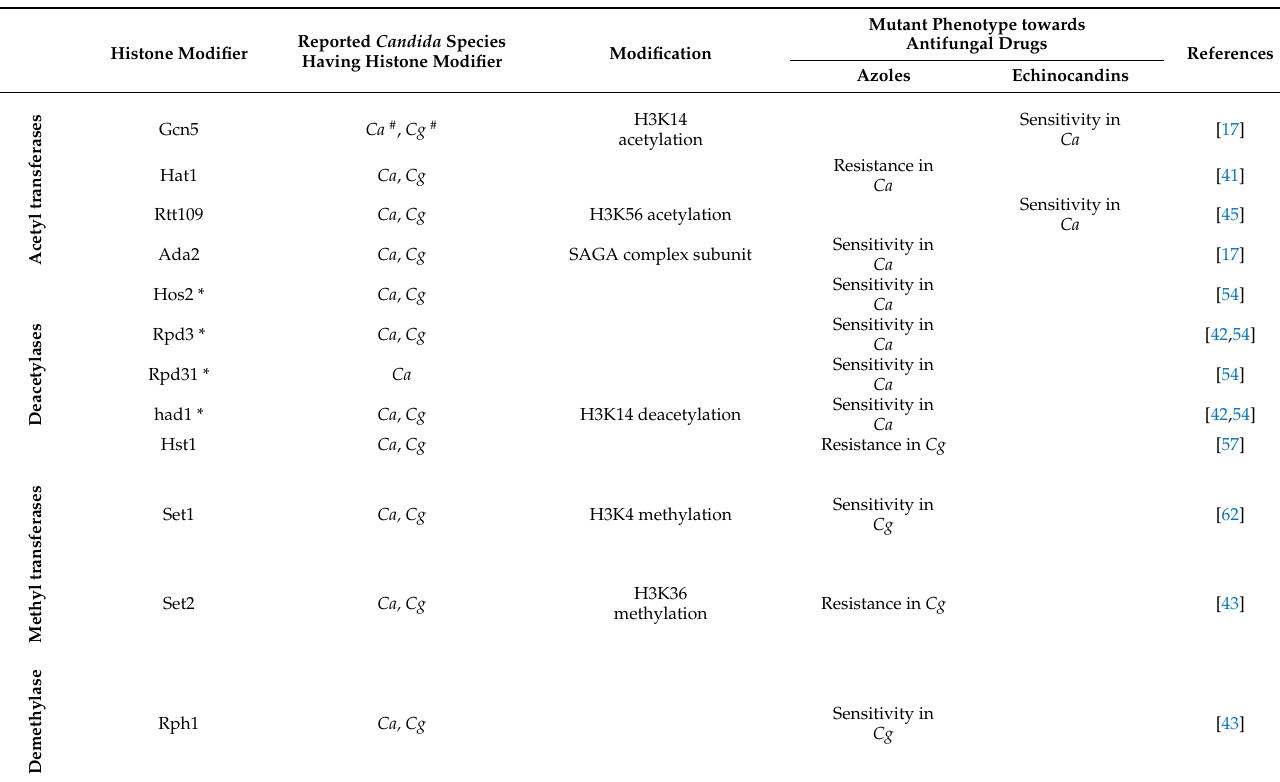
Table 3. List of histone modifiers and their roles in antifungal drug